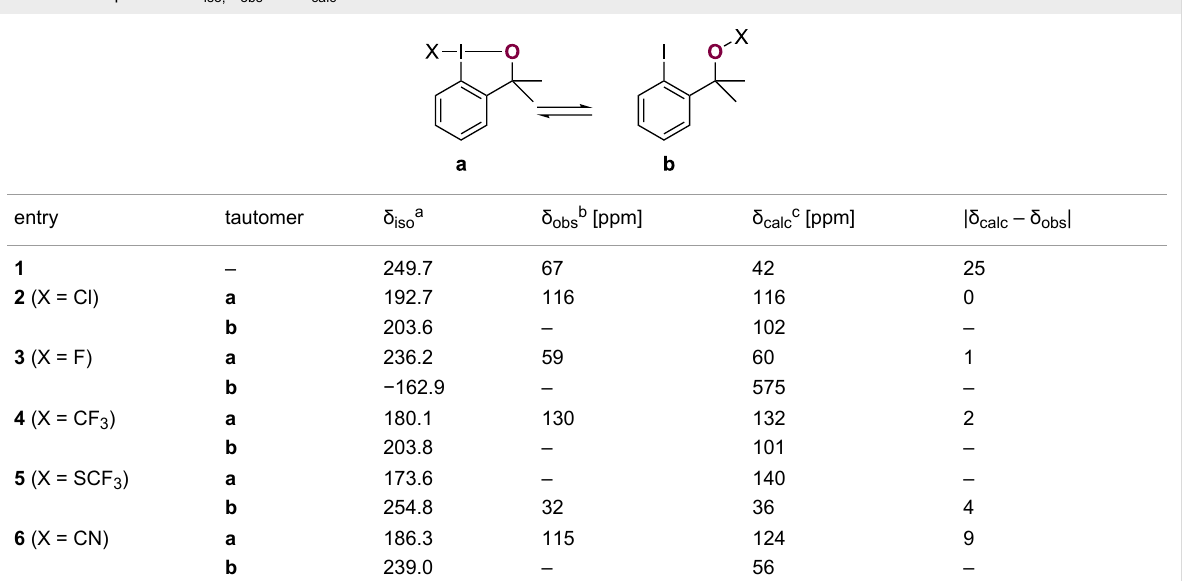
Table 1: Compilation of δ iso, δ obs and δ calc